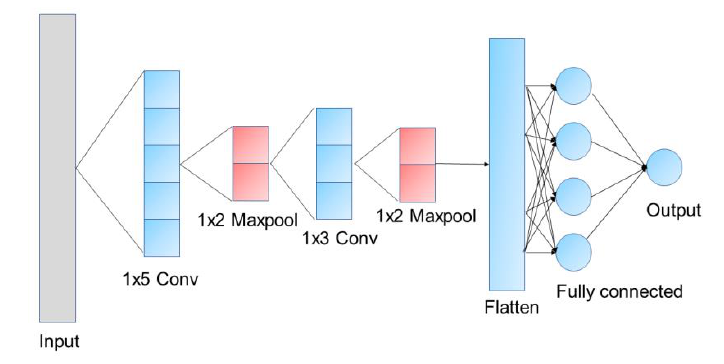
Figure 2. Convolutional neural network temperature prediction model.